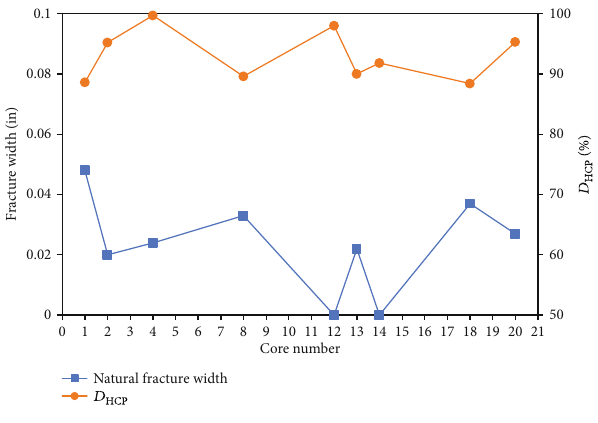
Figure 7: HCP damage of tight sandstone cores. Table 4: XRD results of the tested tight core samples.